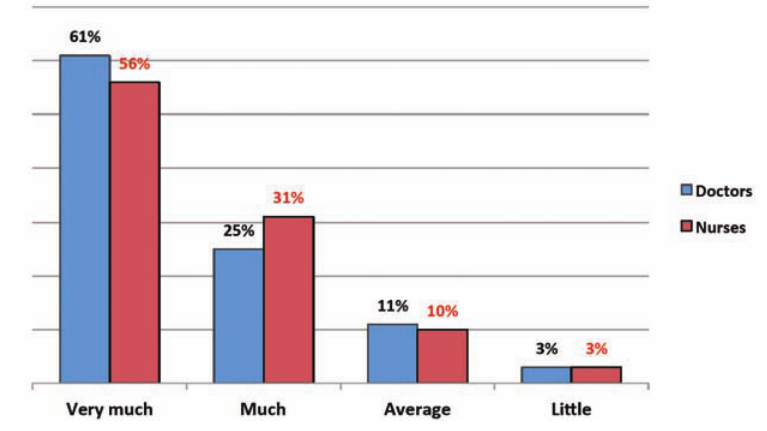
Figure 3. Availability of doctors and nurses (%).